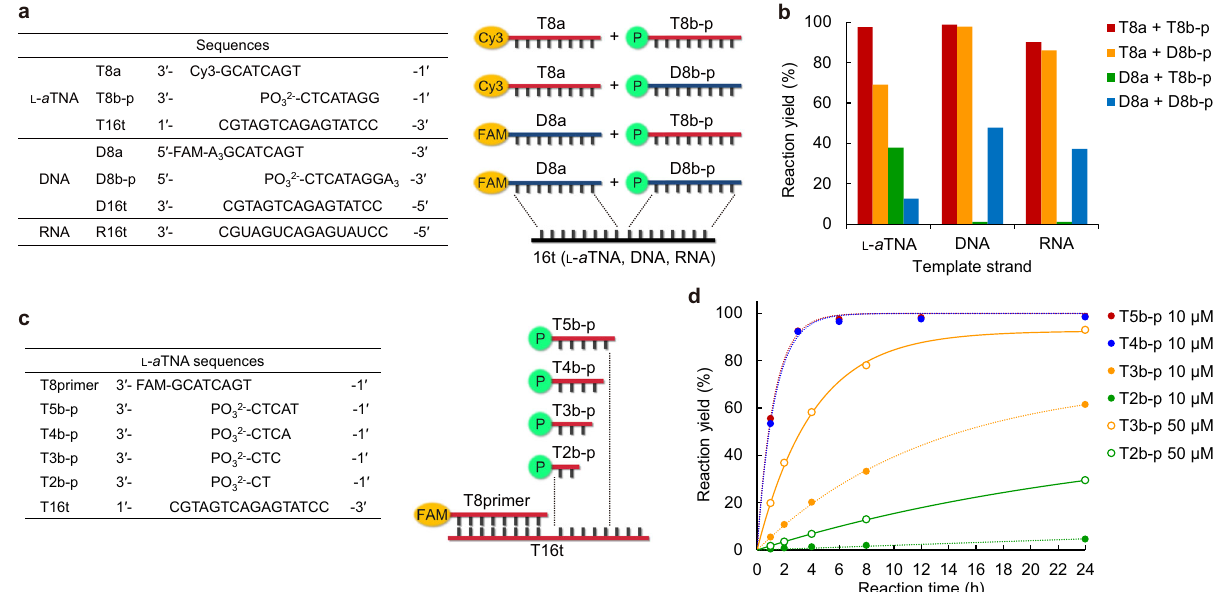
Fig. 3 Homo- and heteroligations and template-directed incorporation of short fragment. a Sequences of 8-mer fragments and 16-mer template. b Ligation yields of indicated pairs of fragments on different templates. T8a/T8b-p (red bars), T8a/D8b-p (yellow bars), D8a/T8b-p (green bars), and D8a/D8b-p (blue bars) were ligated. Conditions: [X8a] = 0.9 μ M, [X8b-p] = 1.1 μ M, [X16t] = 1.0 μ M, [NaCl] = 100 mM, [MnCl 2 ] = 20 mM, [CNIm] = 20 mM, 4 °C, 24 h. Source data are provided as a Source Data fi le. c Sequences of 8-mer primer and fragments and 16-mer template. d Ligation yields for fragments of different lengths as a function of time. 5-mer fragment (red circles), 4-mer fragment (blue circles), 3-mer fragment (yellow circles), and 2- mer fragment (green circles) were used. Conditions: [T8primer] = 0.9 μ M, [T16t] = 1.0 μ M, [NaCl] = 100 mM, [MnCl 2 ] = 20 mM, [CNIm] = 20 mM, concentration of Tnb-p strands is indicated in legend, 4 °C. Source data are provided as a Source Data fi